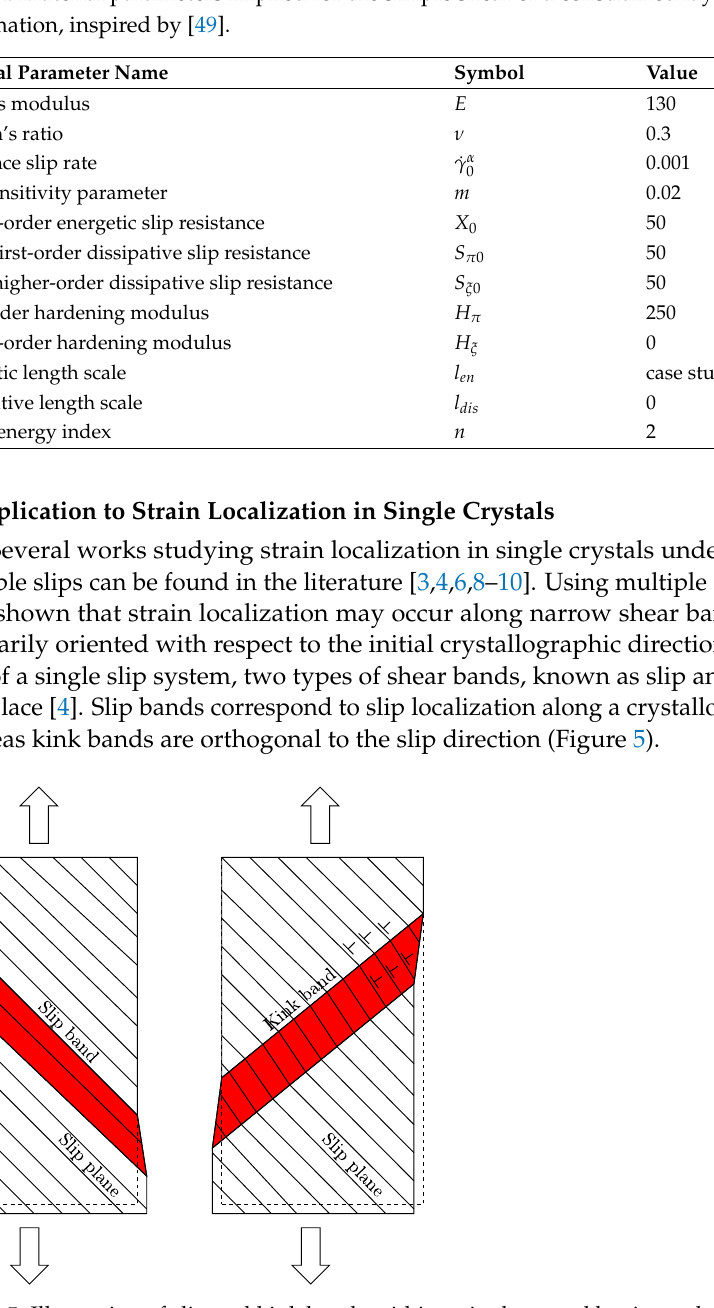
Figure 5. Illustration of slip and kink bands within a single crystal having only one slip system. Due to lack of internal length scale(s), conventional crystal plasticity theories are not able to correctly capture localization bands. As an alternative, Forest [6] has applied a small deformation Cosserat single crystal plasticity theory to investigate the formation